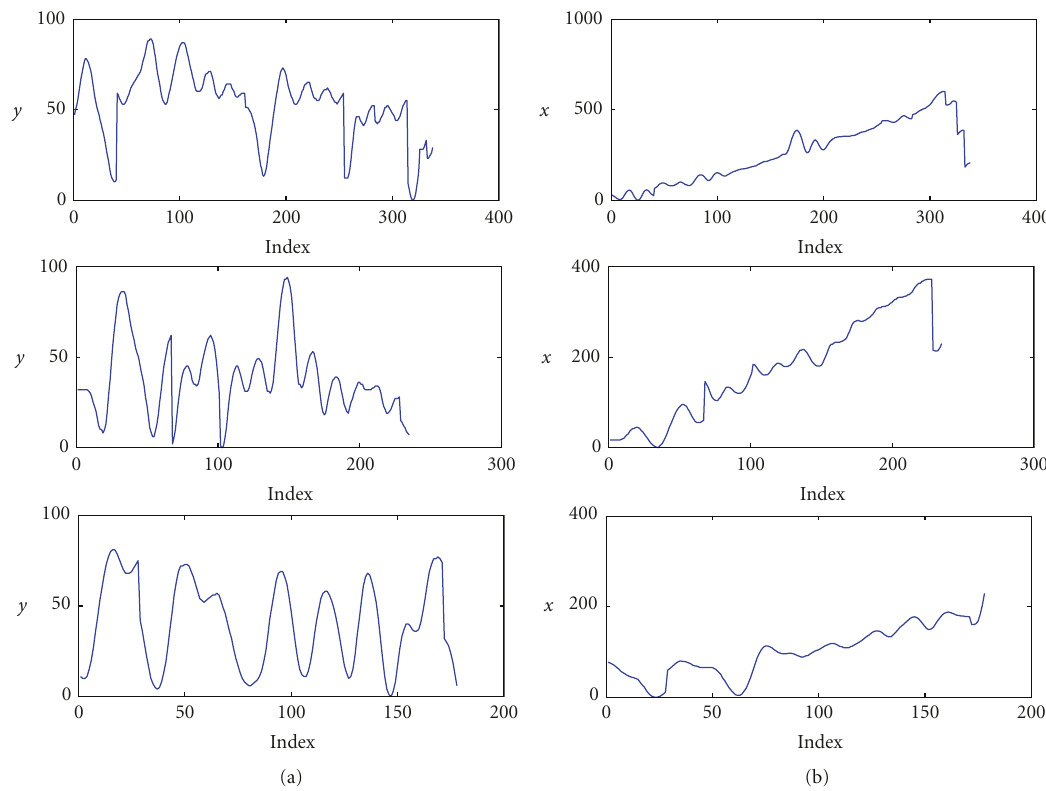
Figure 1: The y -coordinate (a) and x -coordinate (b) profiles belonging to genuine signatures of 3 di ff erent subjects from the SUSIG database.